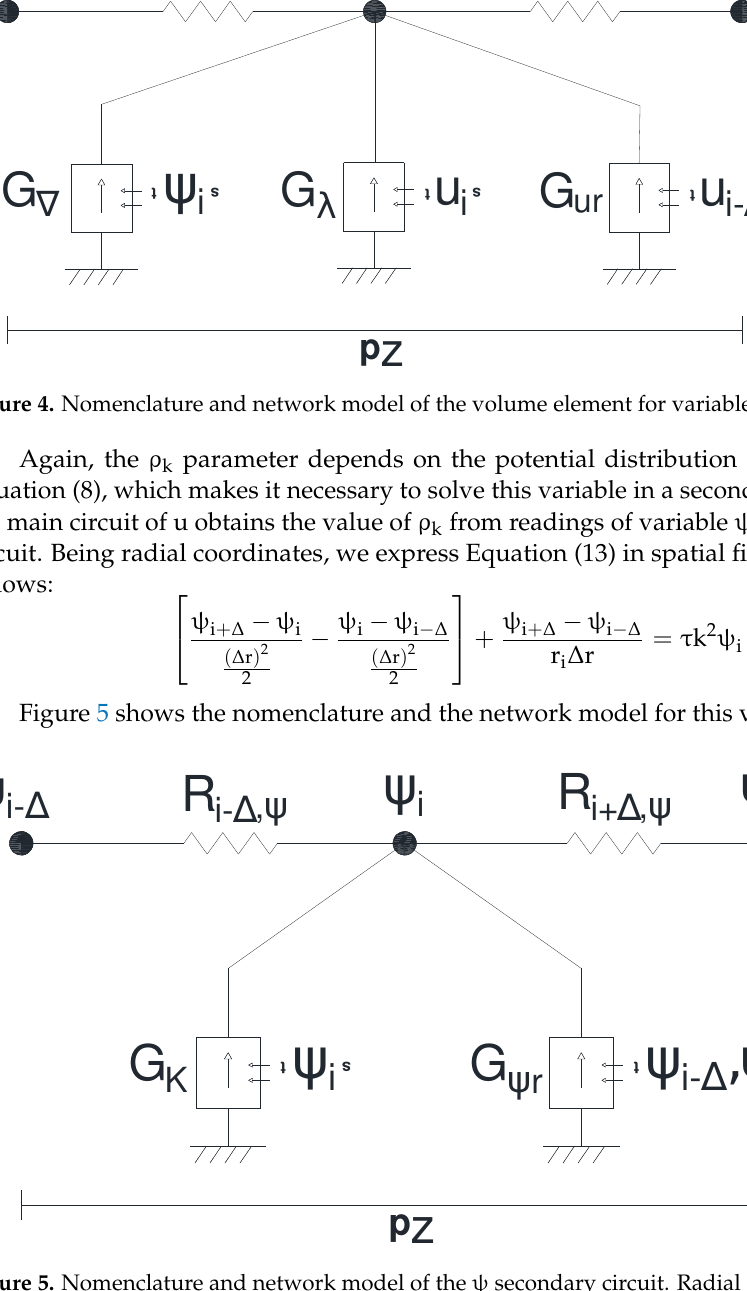
secondary circuit. Radial domains. ψ